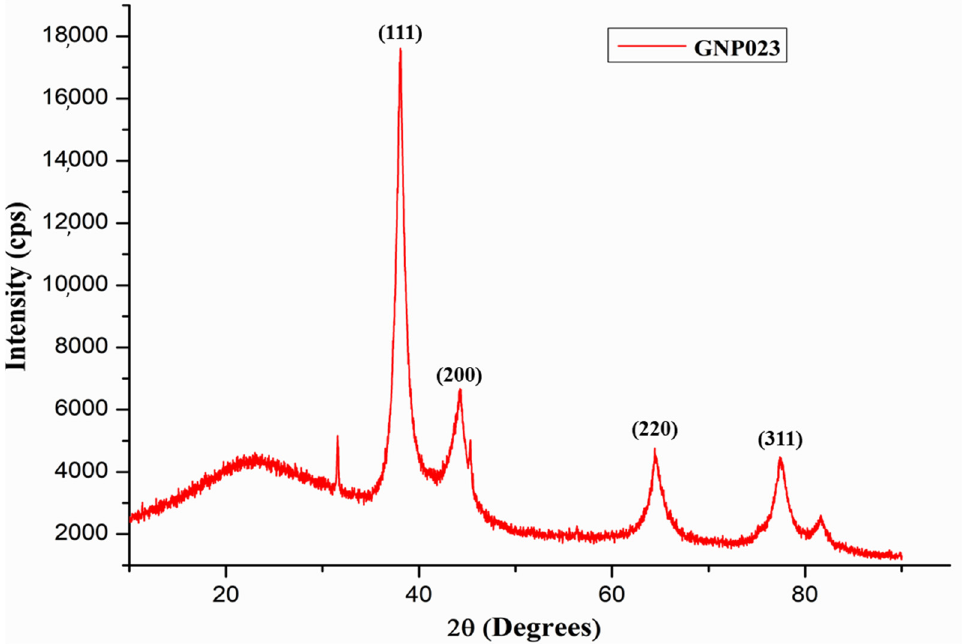
Figure 6. XRD patterns of bio-synthesized gold nanoparticles GNP023.